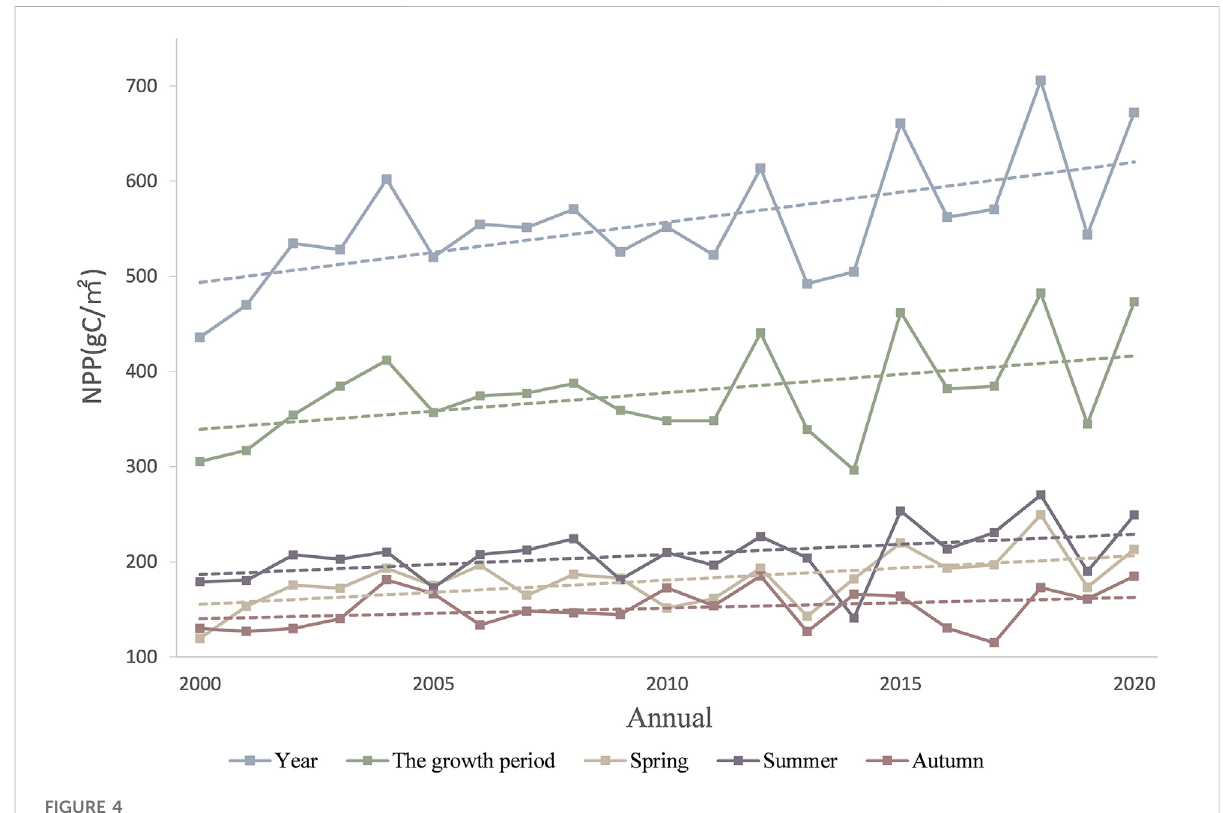
FIGURE 4 Change trend of spatial mean of NPP at different time